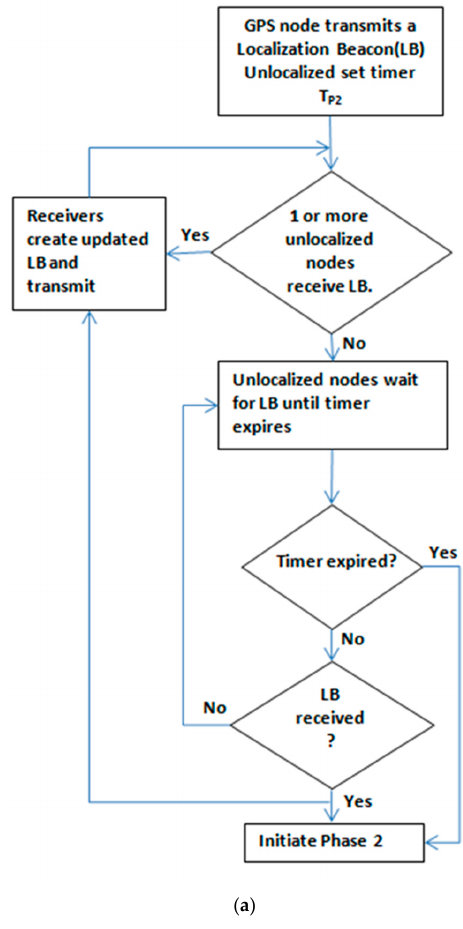
Figure 4. ( a ) Partitioned underwater sensor networks, ( b ) Values of p , and ( c ) Distances between